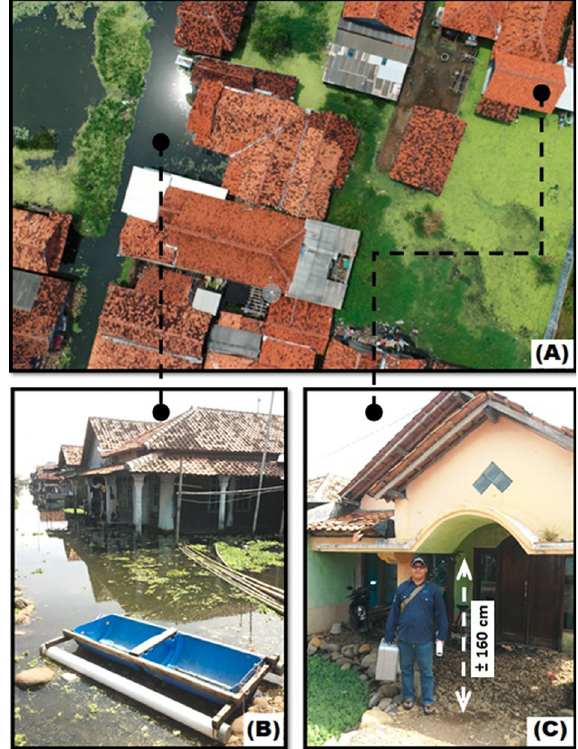
Fig. 1. Environmental conditions in one of the locations affected by tidal flooding in Mulyorejo Village, Tirto District, Pekalongan Regency. (Photos and drone mapping by Yulianto, 2017). A. Tidal flooding seen from a height of 50 m using drone mapping; B. Non-functioning road infrastructure and inundated houses; C. Community adaptation efforts in dealing with the impact of tidal floods by piling up soil, sand and stone in the yard of a